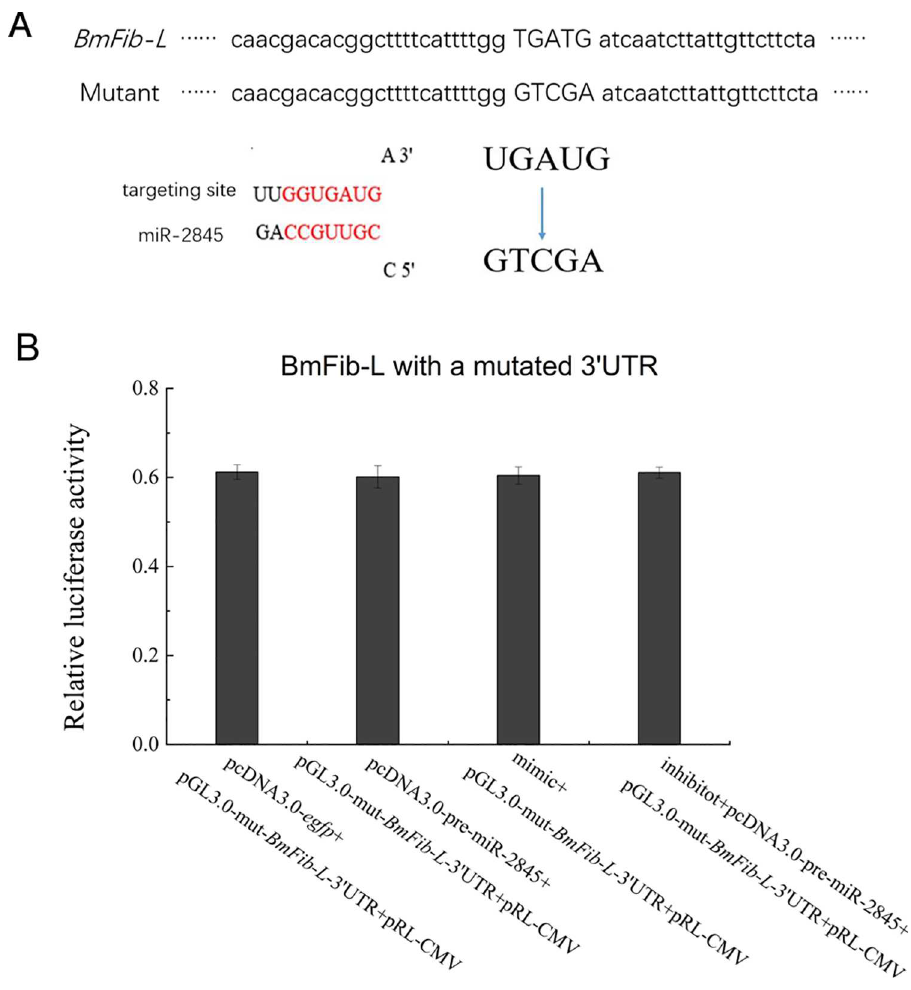
Fig 5. Regulation of bmo-miR-2845 on BmFib-L with a mutated 3’UTR. A. Mutant sequence of BmFib-L -3’UTR. B. Functional verification of bmo-miR-2845 on BmFib-L with a mutated 3’UTR.